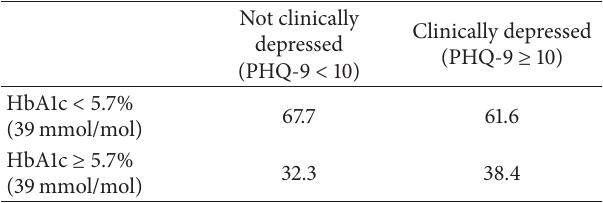
Table 2: Relationship between clinical depression (as measured by the PHQ-9) and HbA1c measures for the nonpregnant United States population ≥ 20 years of age (in %). Not